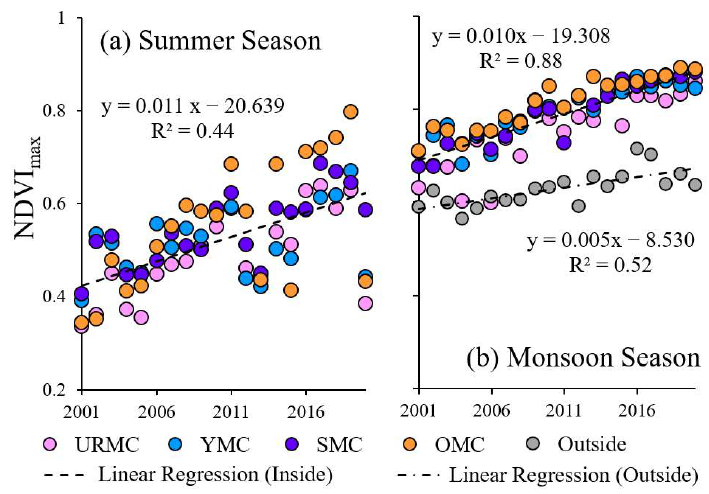
Figure 6. Seasonal peak NDVI for ( a ) summer and ( b ) monsoon by year.